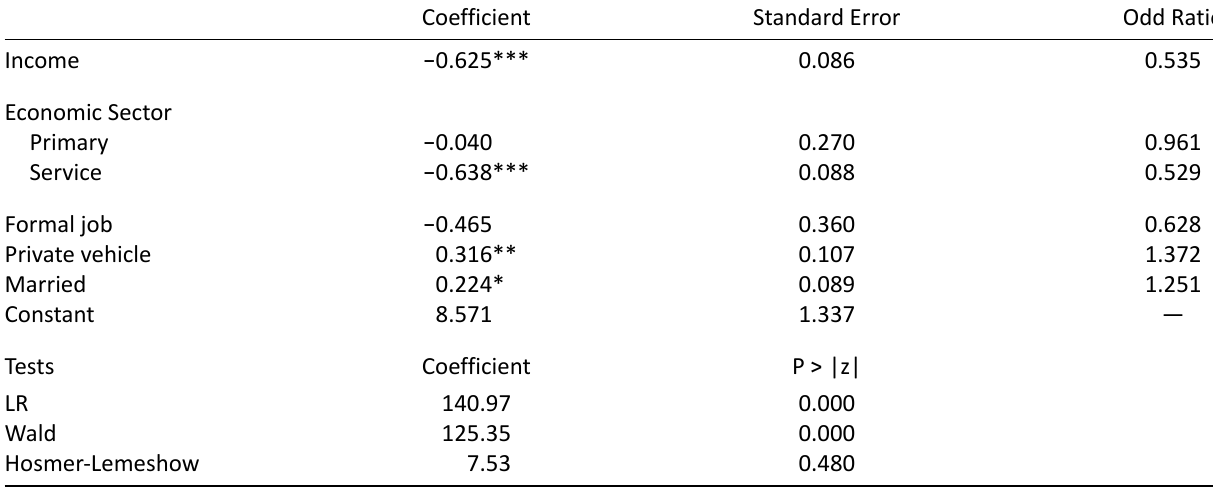
Table 6. Odds ratio of logistic regression of commuting between peripheral